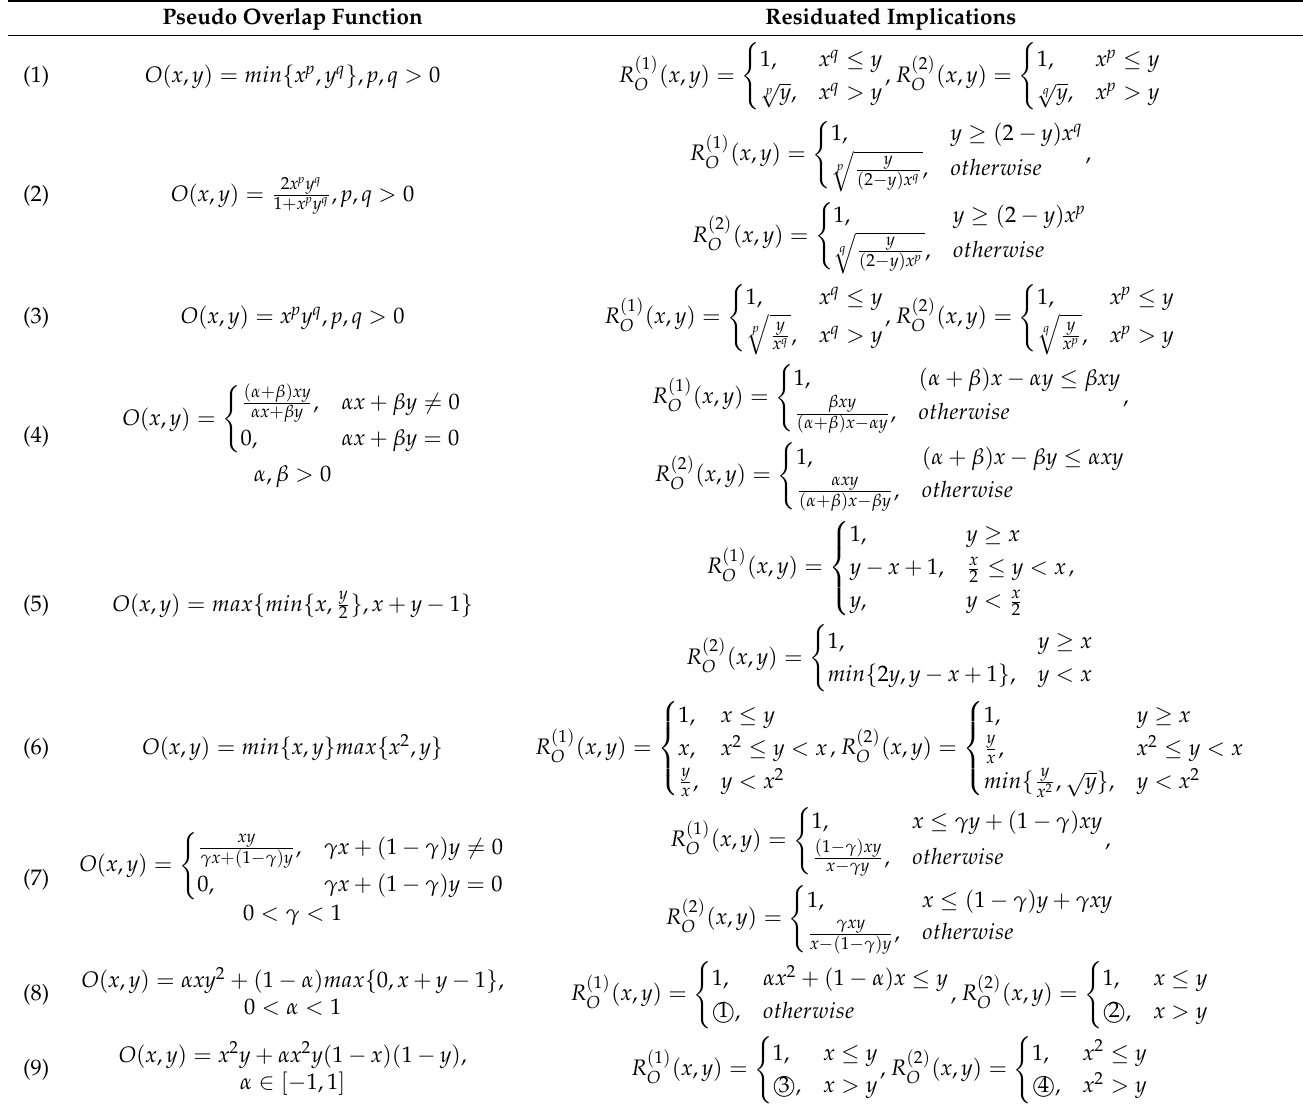
Table 1. Examples of pseudo overlap functions and their residuated